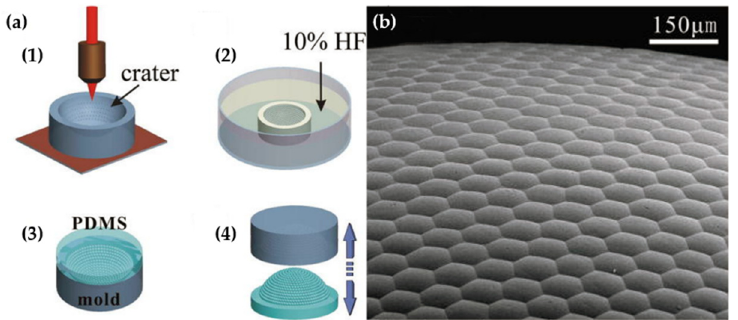
Figure 11. ( a ) The fabrication process of curved MLA using the femtosecond laser enhanced chemical wet etching technique. ( b ) The SEM picture of the fabricated curved MLA. Reprinted from [43], with permission of AIP Publishing.